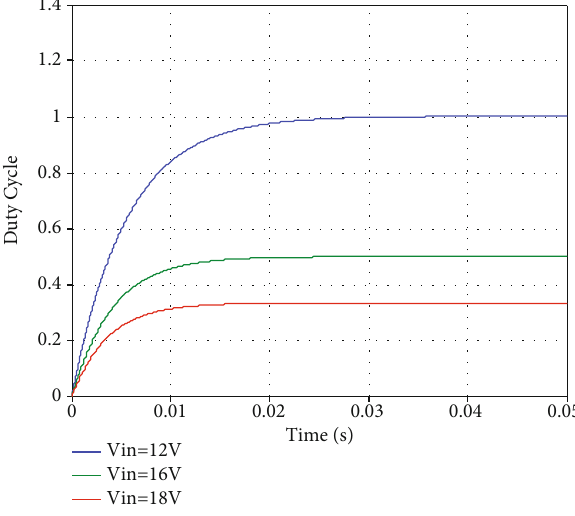
responses of FKYBC for di ff erent V o